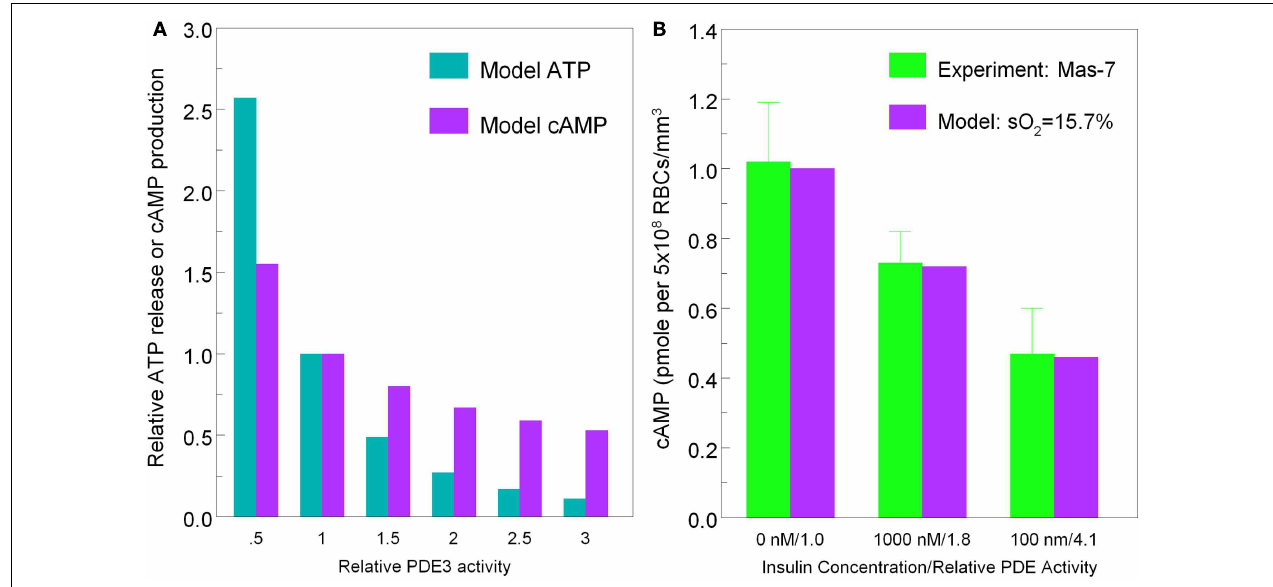
to Mas-7 stimulation vs. insulin concentration (0, 1mM, 100nM) and model predictions of cAMP production (purple bars) at 15.7% sO 2 vs. PDE3 activity (PDE3 rel = 1, 1.8,